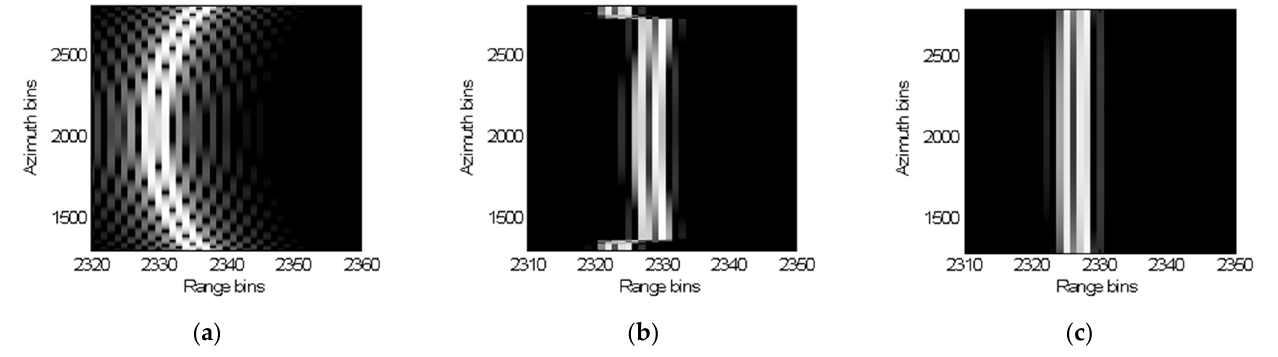
Figure 5. Comparison of range profiles of points 1 and 2. ( a ) Range profile of points 1 and 2 before RCMC; ( b ) RCMC results without using one-step MOCO method; ( c ) RCMC results after one-step MOCO method.